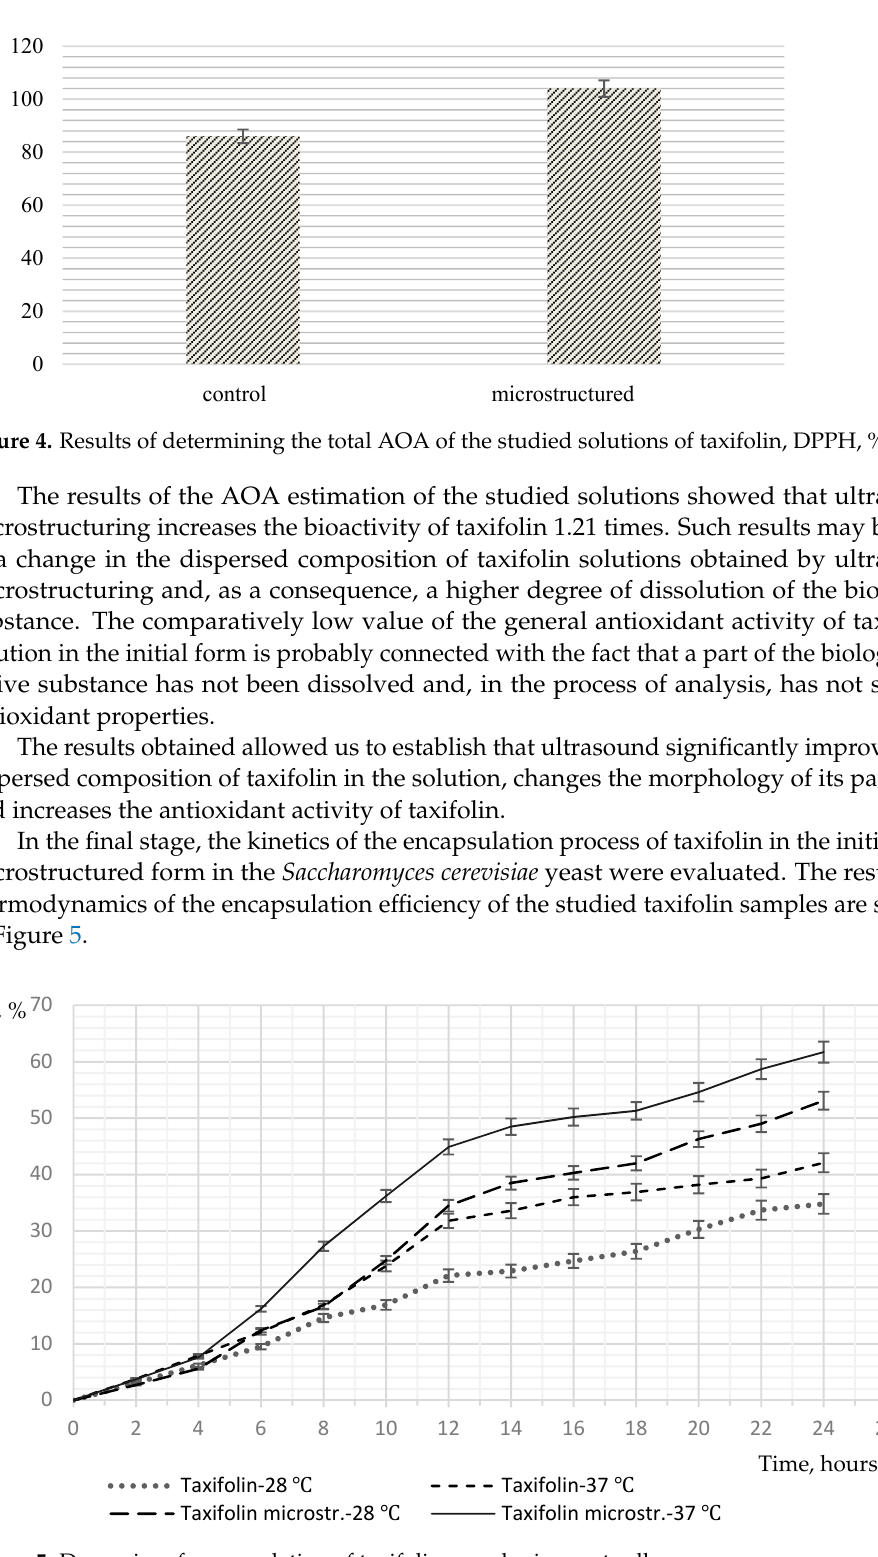
Figure 3. Morphology of taxifolin particles of the studied solutions (×1000 ): ( a ) control; ( b ) micro- structured (ultrasound 600, 7 min).